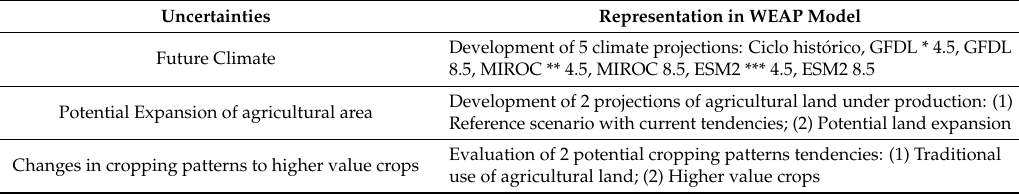
Table 4. List of Uncertainties (Xs) identified for the study area, corroborated by the local institutions focus group.